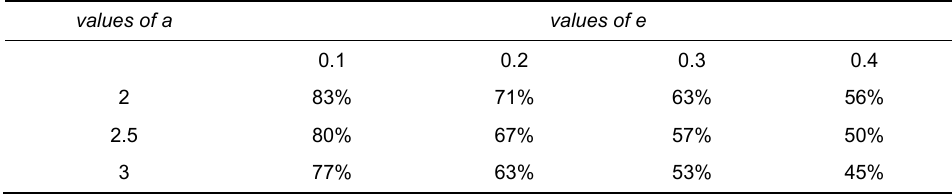
Table 1: The revenue-maximising top marginal tax rate as a function of a and e values of a